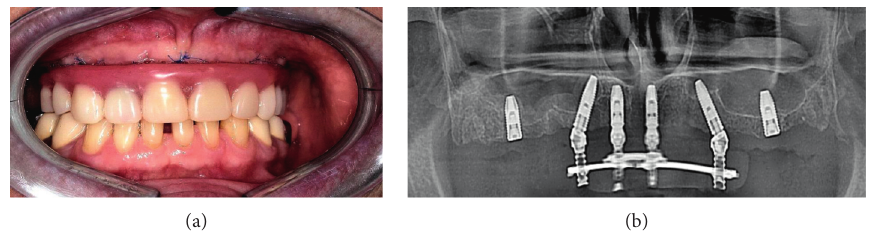
Figure 21: Immediate loading on the day of surgery using multiunit system and radiographic control.